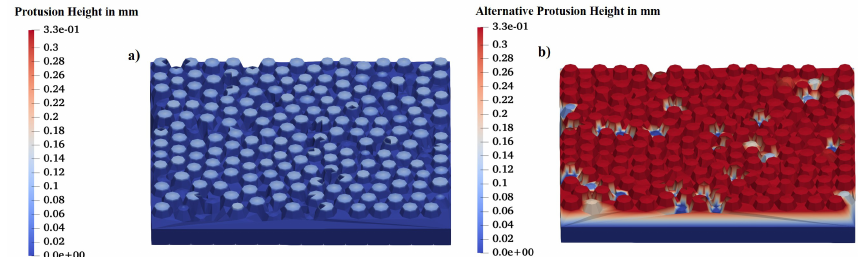
Figure 43. Grit 20 surface topography comparsion for ( a ) protrusion height and ( b ) alternative protrusion height.